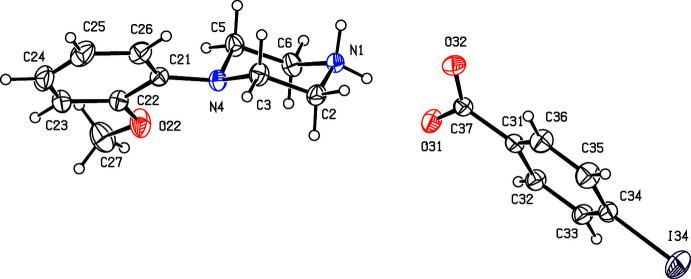
The independent components of compound (III) showing the atom-labelling scheme. Displacement ellipsoids are drawn at the 30% probability level.